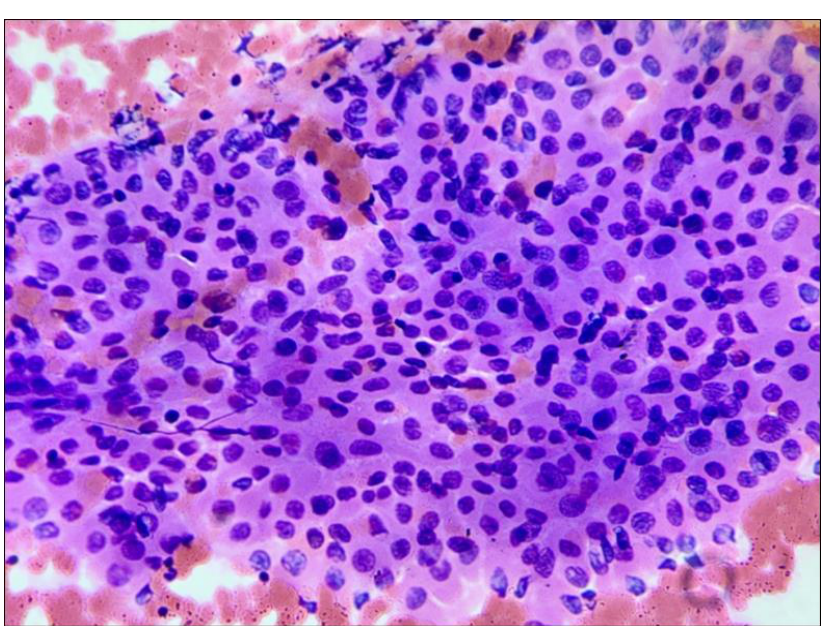
Fig. 3. Warthin’s Tumour Cytology showing sheets of oncocytic cells with regular round nuclei. (H&E, 400X). Smears of Adenoid cystic carcinoma were highly cellular and showed granular cytoplasm. Nuclei were round, monomorphic, had granular numerously scattered and loose clusters of acinar cells. Cells were large but chromatin, and a few showed inconspicuous nucleoli (Fig. 4). morphologically resembled normal acinar cells and showed abundant